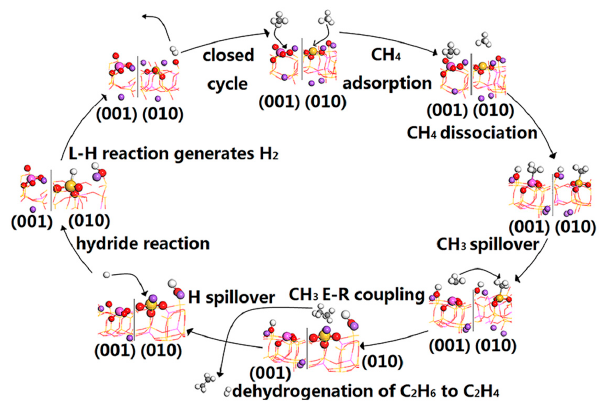
Figure 6. Schematic diagram of the path for activation and conversion of CH 4 by albite catalyst.